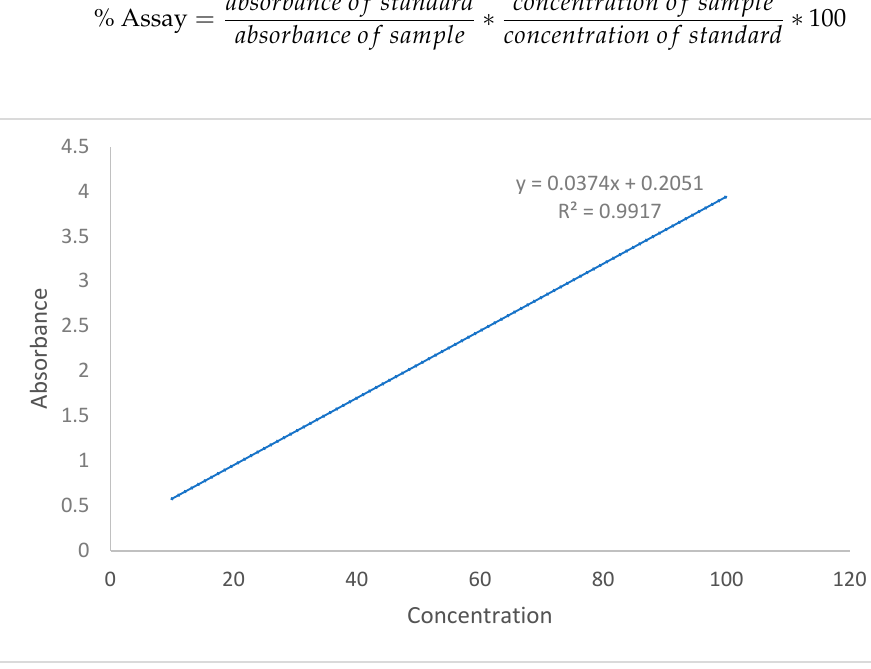
Figure 9. Calibration curve for linearity.